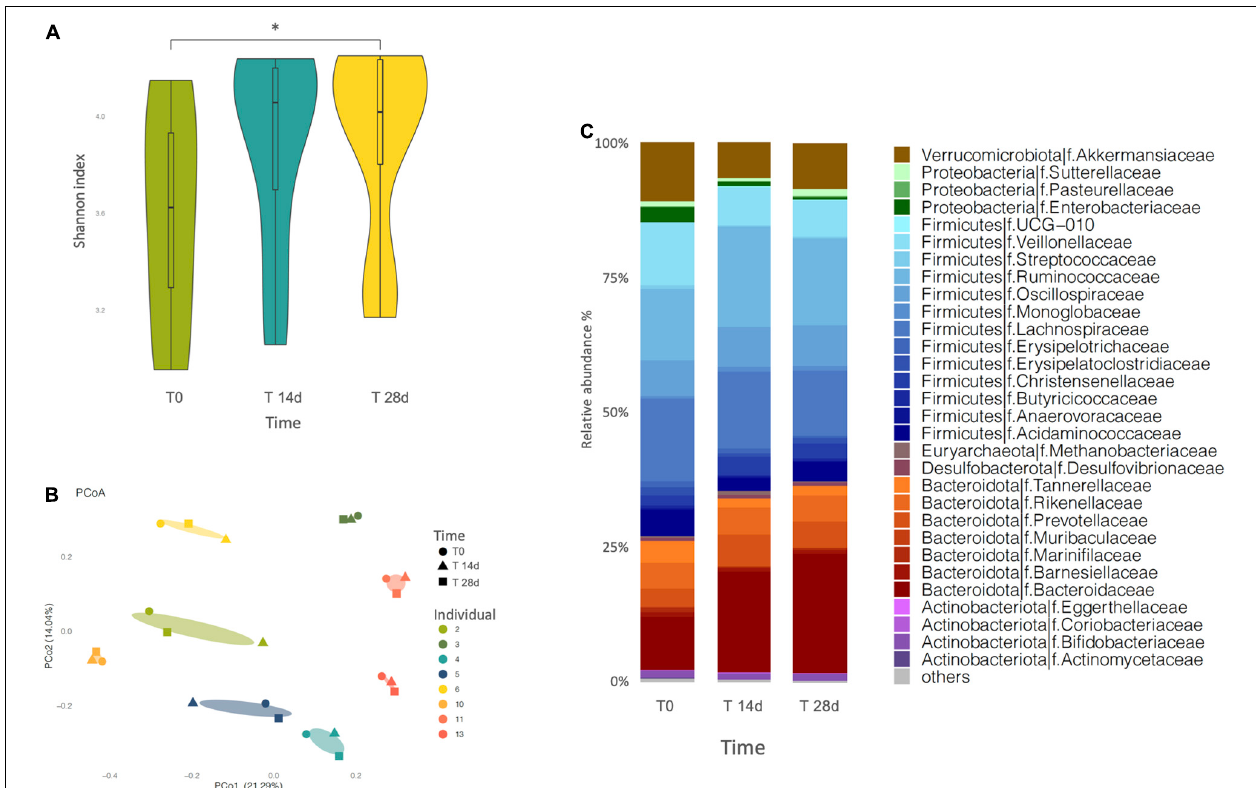
FIGURE 2 | (A) Variation of the Shannon index of microbiota diversity throughout the intervention. Diversity increases significantly only at T28d ( p = 0.0078, adjusted p = 0.016). “ ∗ ” indicates the statistically significant difference. (B) Principal coordinate analysis (PCoA) plot of total variation based on Bray-Curtis dissimilarity of microbial genus abundance among all profiled samples. The samples cluster by individual. (C) Barplot of gut microbial community structure at family level, at three different times of the intervention (T0, T14d, and T28d). Relative abundances were obtained by total-sum scaling (TSS) from the genus-level abundance